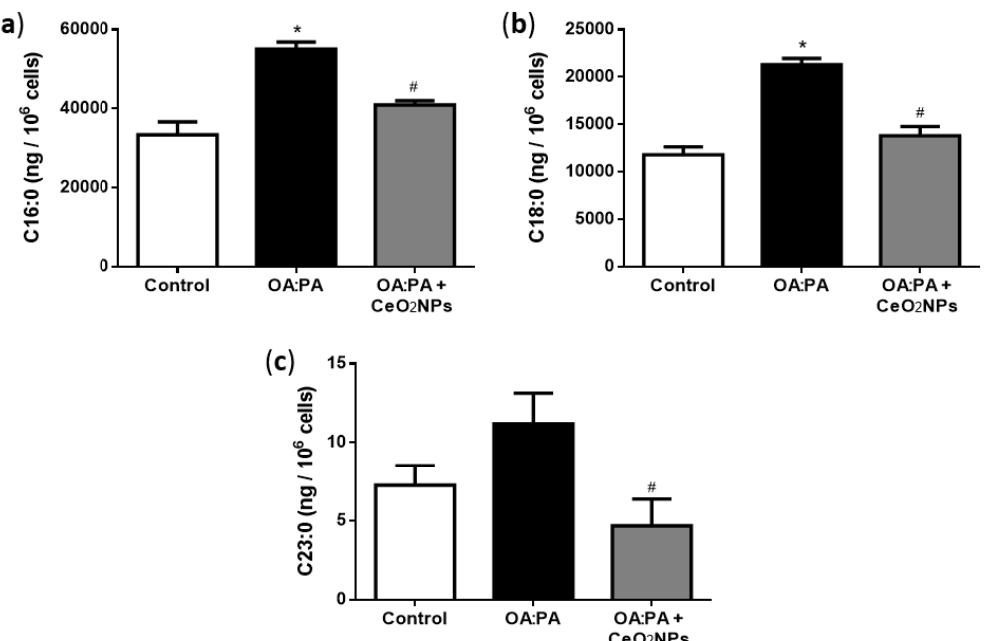
Figure 5. Palmitic (C16:0) ( a ), stearic (C18:0) ( b ) and tricosanoic (C23:0) ( c ) acid content in control cells, cells incubated with OA:PA (1.33:0.67 mM) and cells incubated with OA:PA treated with CeO 2 NPs (10 µ g / mL). * p < 0.05 compared with control; # p ≤ 0.05 compared with OA:PA.